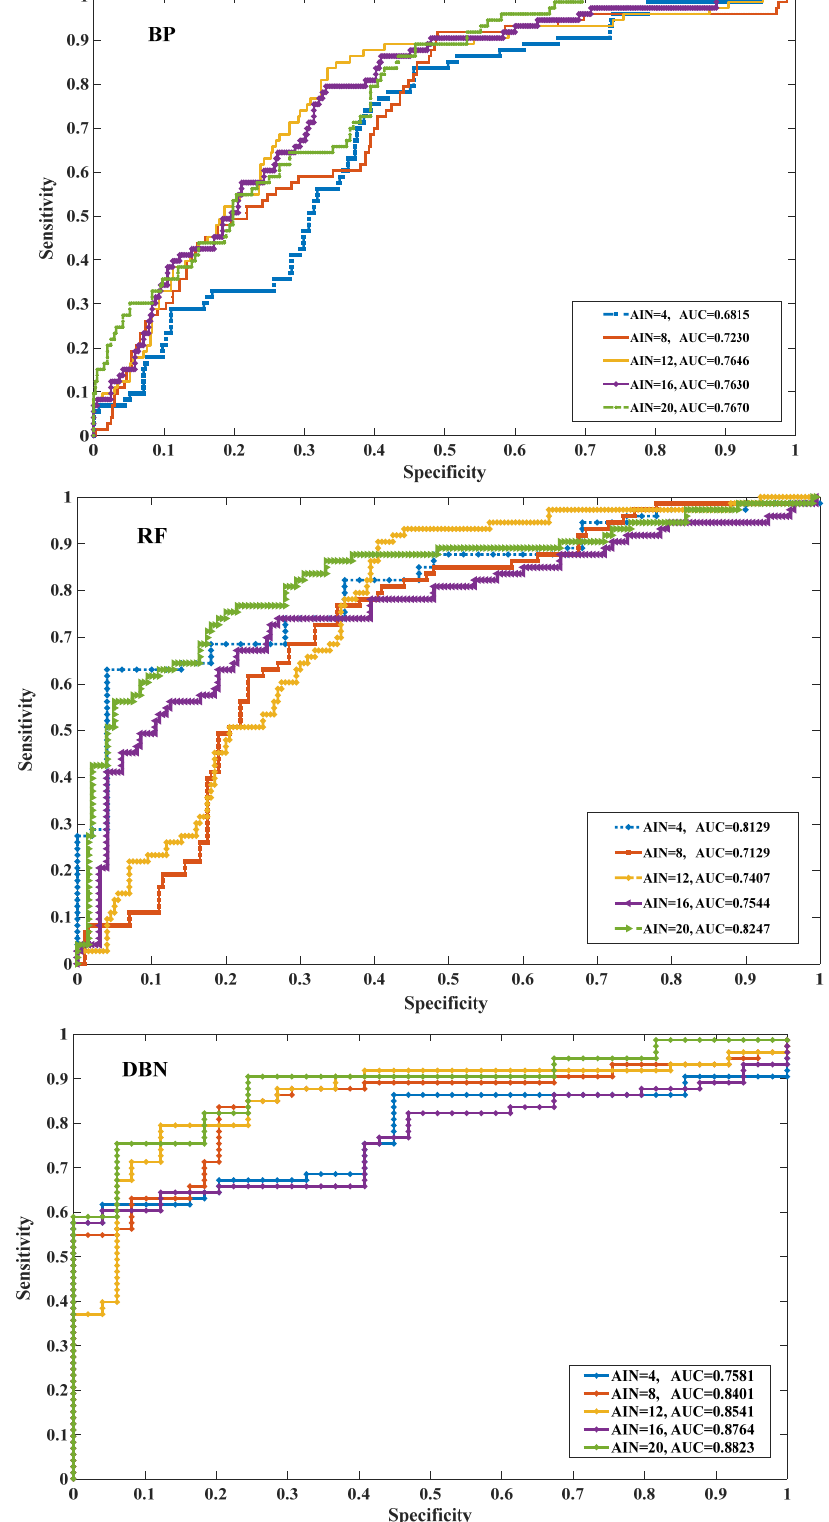
Figure 7. ROC curves of each model and di ff erent AINs.